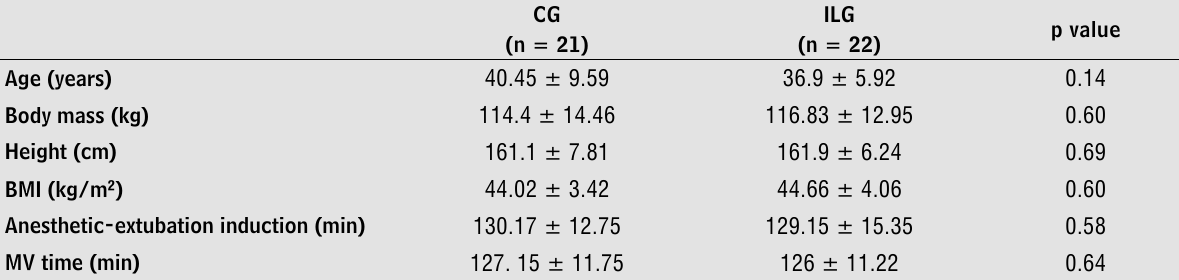
Table 1 – Age, anthropometric characteristics and surgeries of the participants assigned to the